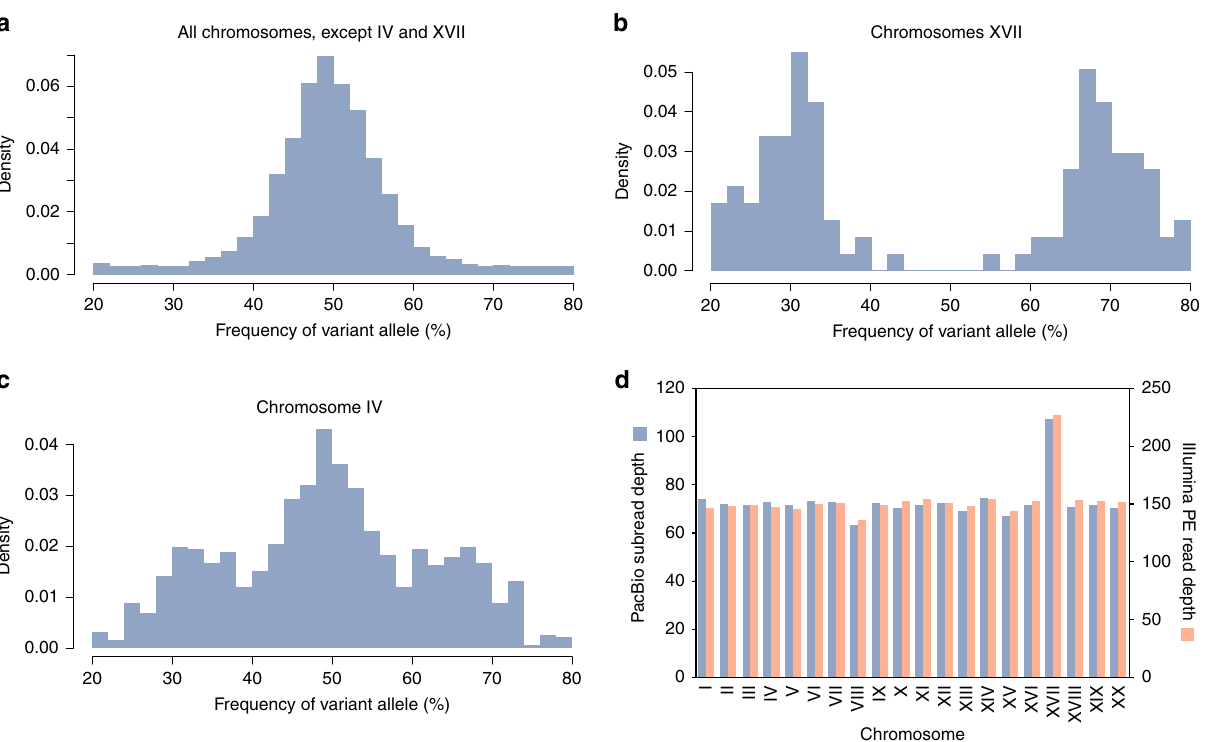
Fig. 4 Allelic frequencies of SNPs and small indels, and coverage depth of sequencing reads on Chloropicon chromosomes. a Allelic frequency distribution observed for all chromosomes, except IV and XVII. b Allelic frequency distribution observed for chromosome XVII. c Allelic frequency distribution observed for chromosome IV. d Mean PacBio and Illumina (paired-end) sequencing depths of each chromosome. Source data are provided as a Source Data fi